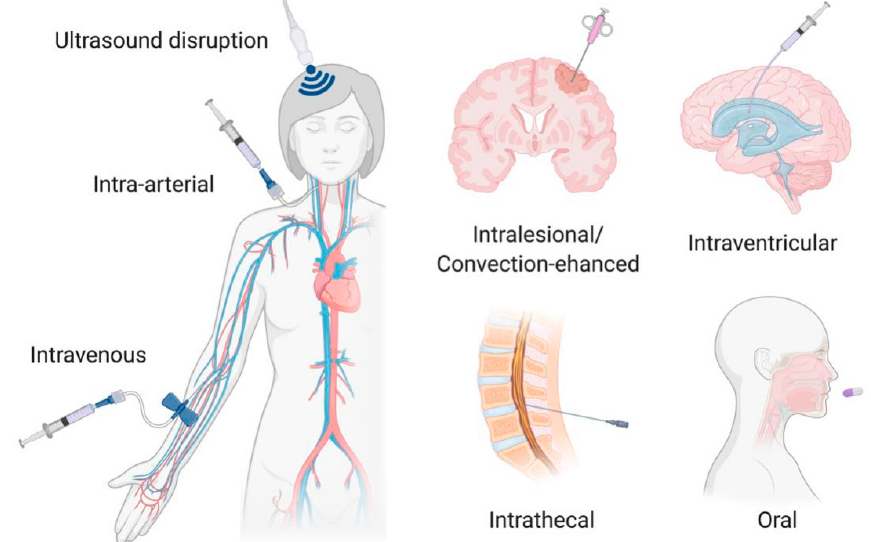
Figure 3. Administration routes and adjuvant technologies in current use for treatment of CNS tumors. Figure created with BioRender.com.